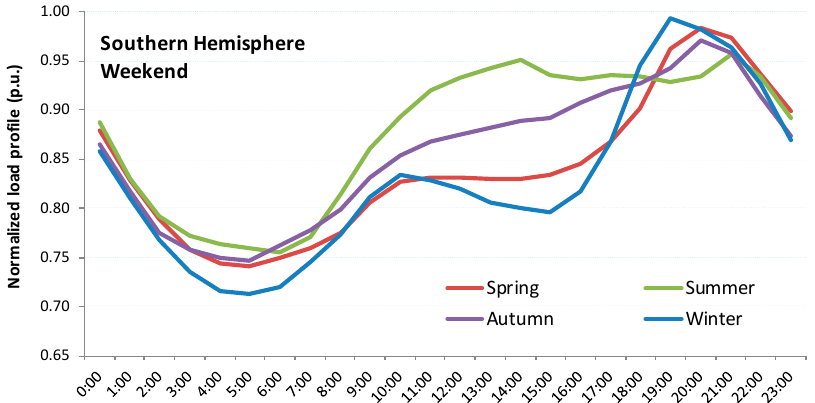
Figure 9. Standard normalised demand profiles for weekdays in the Northern Hemisphere. Source: [65,80–82] and self-elaboration.